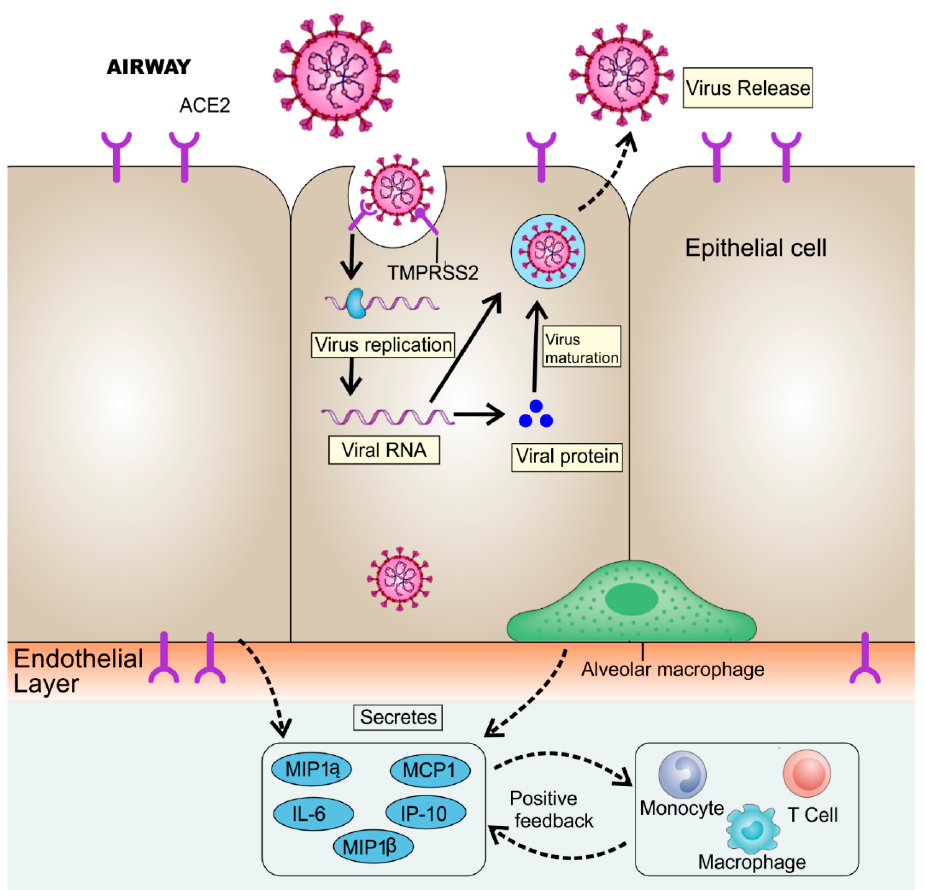
Figure 2. Inflammatory responses during severe acute respiratory syndrome coronavirus (SARS-CoV-2) infection. SARS-CoV-2 attaches to the ACE2 receptor, and the spike protein is cleaved by the type II transmembrane serine protease (TMPRSS2), resulting in viral replication. Mature viruses are released from the cell by exocytosis. In the dysfunctional immune response, cells may undergo pyroptosis and release adenosine triphosphate (ATP), nucleic acids, and ASC oligomer. These impaired-associated molecular forms can be detected by the neighboring epithelial cells and other alveolar macrophages. In response, the pro-inflammatory cytokines are released along with chemokines, including IL-6, IP-10, macrophage inflammatory protein 1 α (MIP1 β ), MCP1, and MIP1 α . These released proteins draw